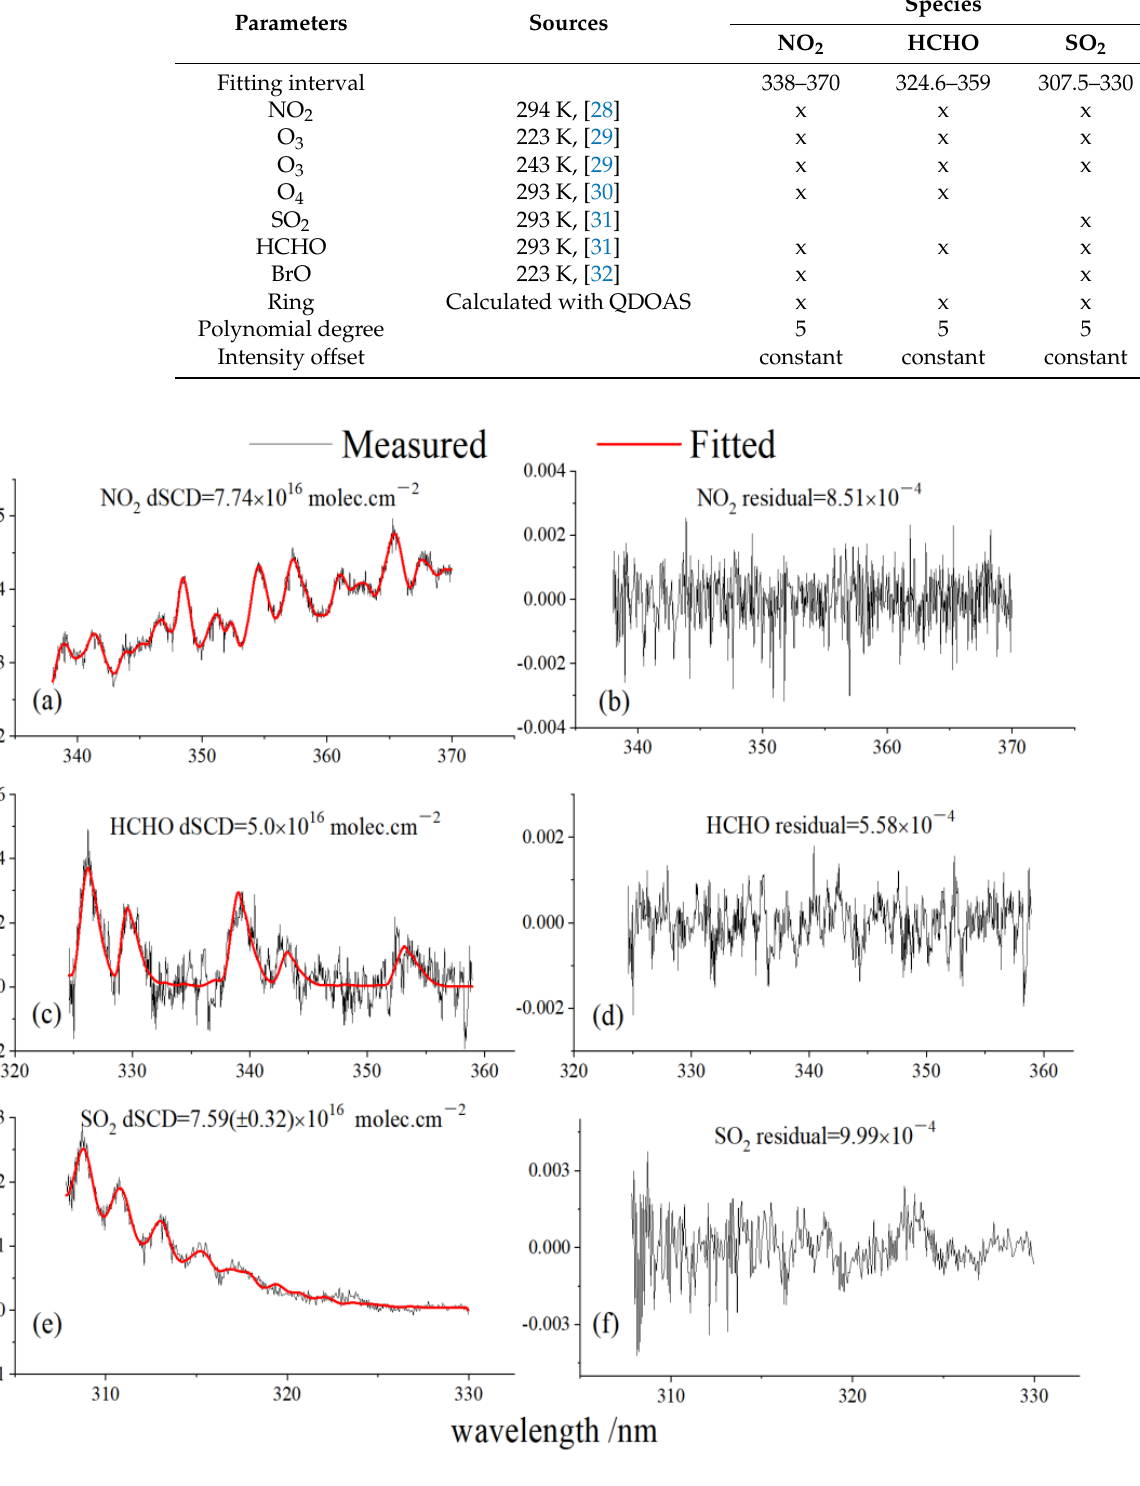
Figure 2. Examples of typical DOAS fits for NO 2 ( a ), HCHO ( c ) and SO 2 ( e ) at 30° elevation angle. Residuals for NO 2 ( b ), HCHO ( d ) and SO 2 ( f ) are given in the corresponding subfigures. The red and black curves indicate the fitted absorption structures and the derived absorption structures from the measured spectra, respectively.